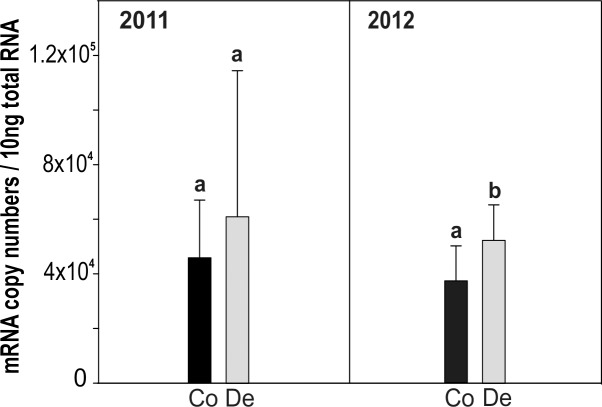
Differential CdMT gene expression in the Roman snail triggered by desiccation.The experiment was carried out two times, presented by the year dates 2011 (left hand side) and 2012 (right hand side). Means and +SD of CdMT mRNA copy numbers of controls (Co, black bars) and snails exposed to desiccating conditions (De, grey bars) are displayed. Significance is indicated by asterisk (P<0.05).